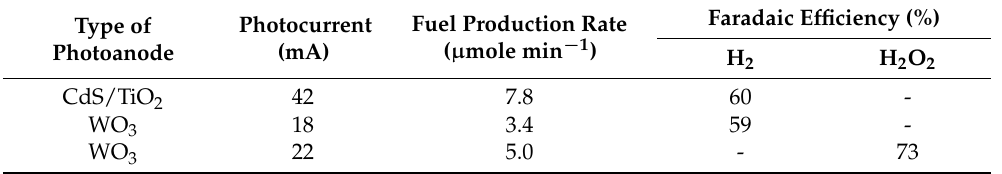
Table 1. Photocurrent values and Faradaic efficiencies for photoelectrocatalytic hydrogen or hydrogen peroxide production by reduction reactions at the counter-electrode.